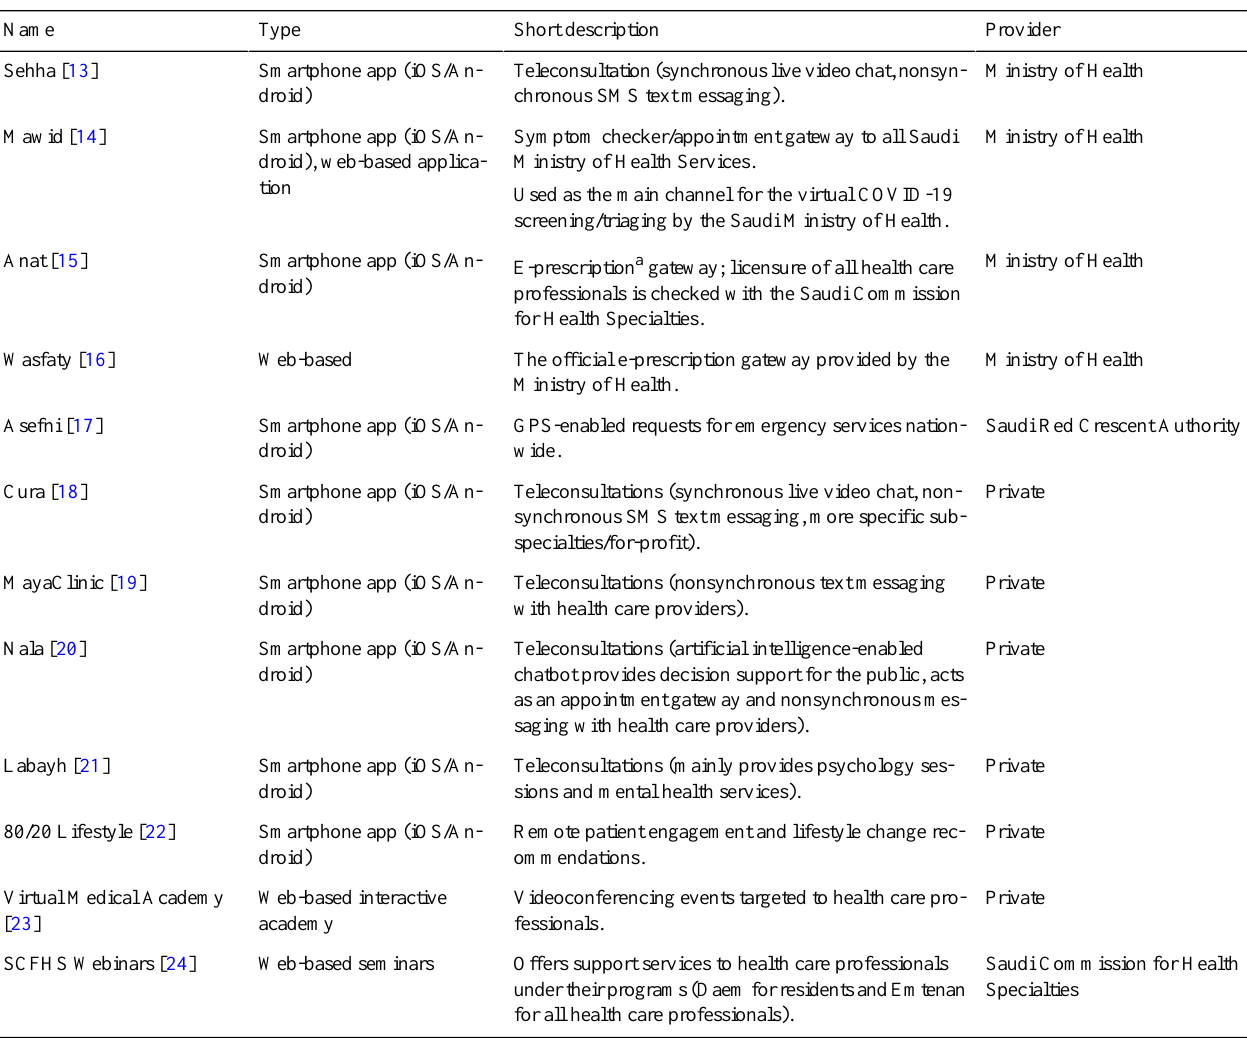
Table 1. Summary of telehealth applications available in Saudi Arabia during the COVID-19